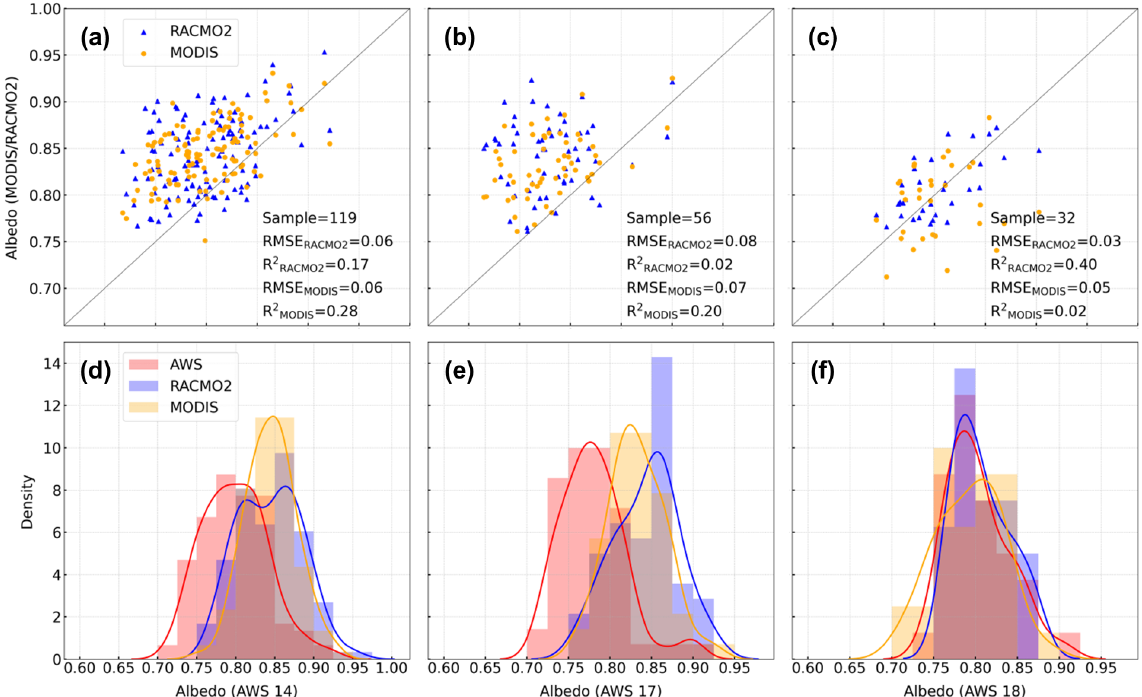
Figure 6. Scatterplots illustrating albedo difference under clear-sky conditions during austral summers between automatic weather sta- tion (AWS) and Moderate Resolution Imaging Spectroradiometer (MODIS) observations, and albedo difference between AWS observations and regional atmospheric climate model version 2.3p2 (RACMO2) simulations in (a) AWS 14, (b) AWS 17, and (c) AWS 18, along with their corresponding distributions in (d) AWS 14, (e) AWS 17, and (f) AWS 18. RMSE and R 2 stand for the root-mean-square error and the coefficient of determination, respectively.